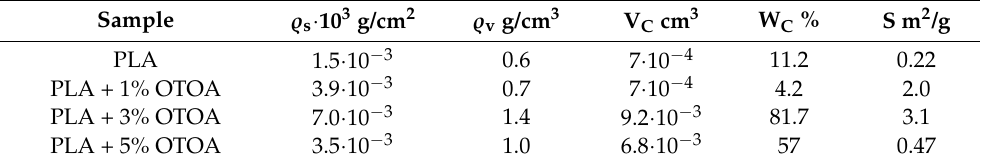
Table 2. Surface ( (cid:36) s ) and bulk ( (cid:36) v ) density, open volume of the capillaries (V C ), proportion of the open volume of the capillaries to the total volume of the material (W C ) and specific surface area (S) for the nonwoven PLA fiber mats with different amounts of added